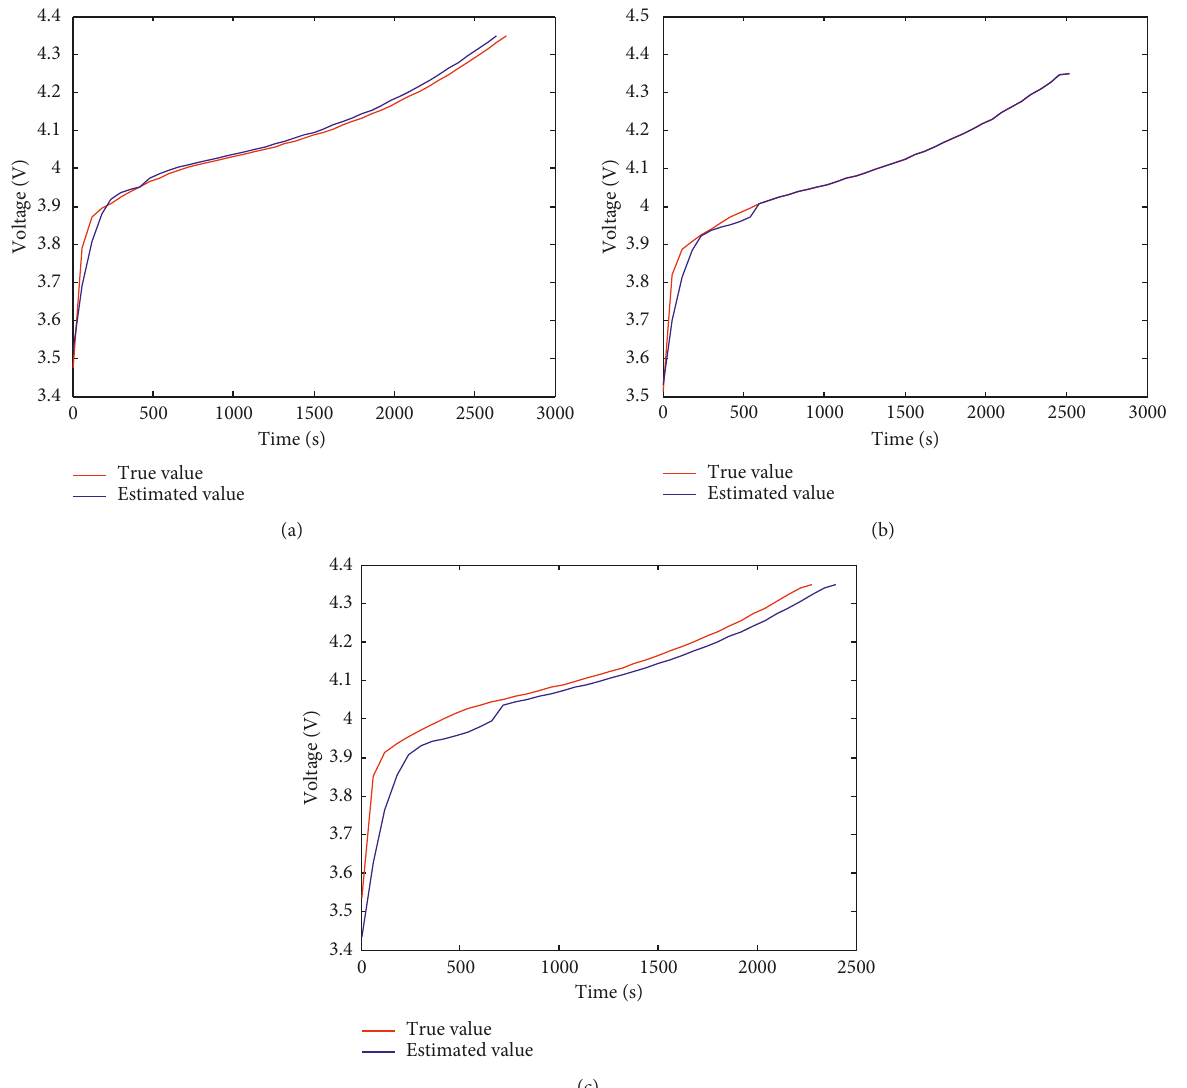
Figure 5: Comparisons between actual and estimated voltage-tine curve of 100 (a), 200 (b), and 1000 (c) charge cycles for battery